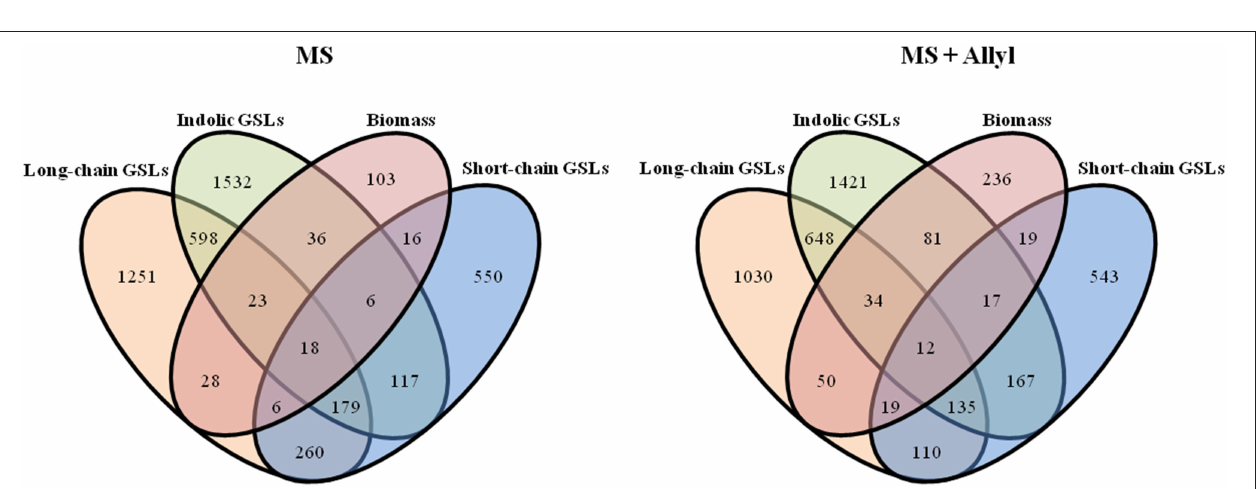
FIGURE 4 | Overlap of significant GWA candidate genes between control (MS) and treated samples with 50 µ M of allyl GSL (MS + Allyl GSL). VENN diagram showing common candidate genes identified among the plant biomass, short-chain GSLs, long-chain GSLs, total aliphatic GSLs, total incolic GSLs, and total GSLs traits.